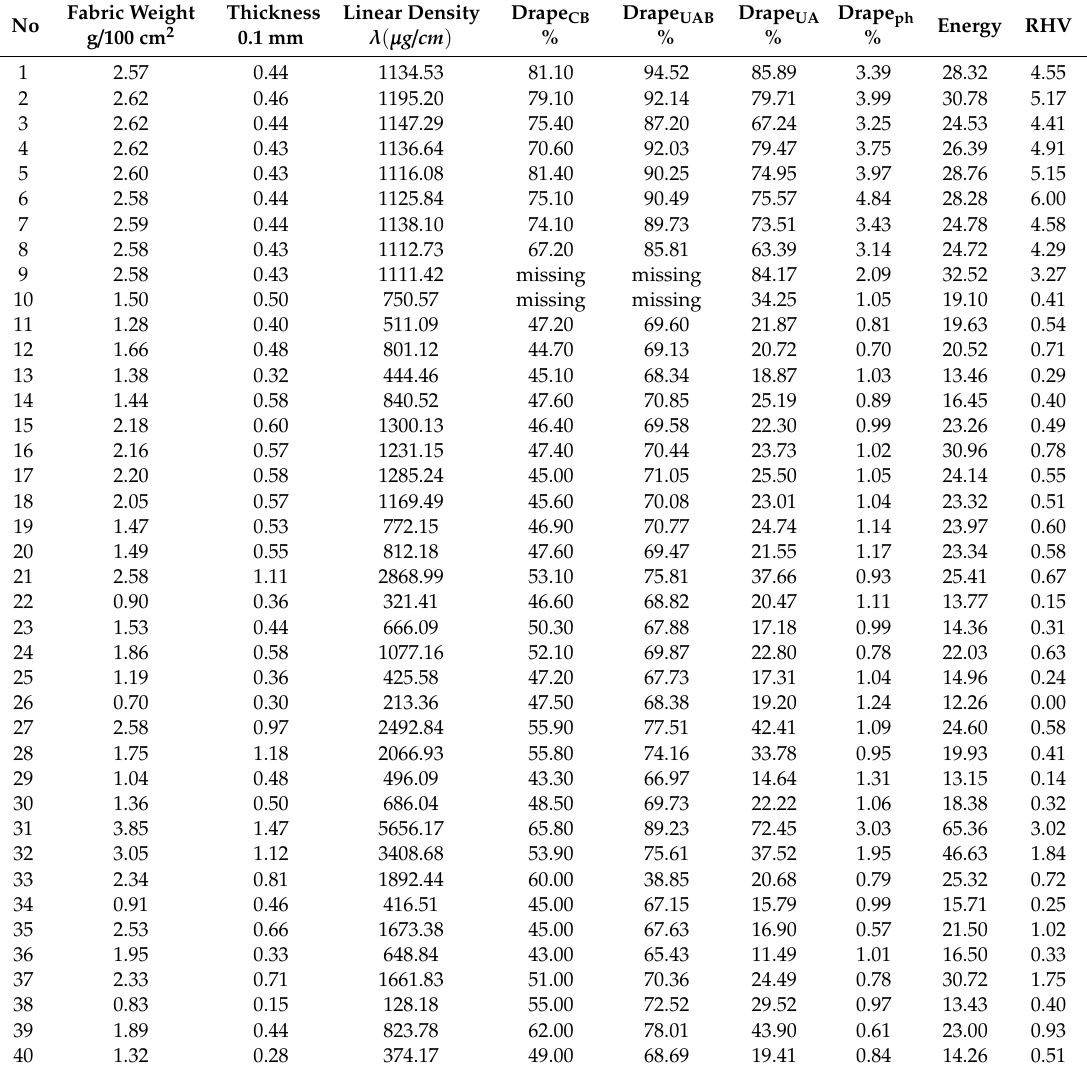
Table 5. Correlations between the